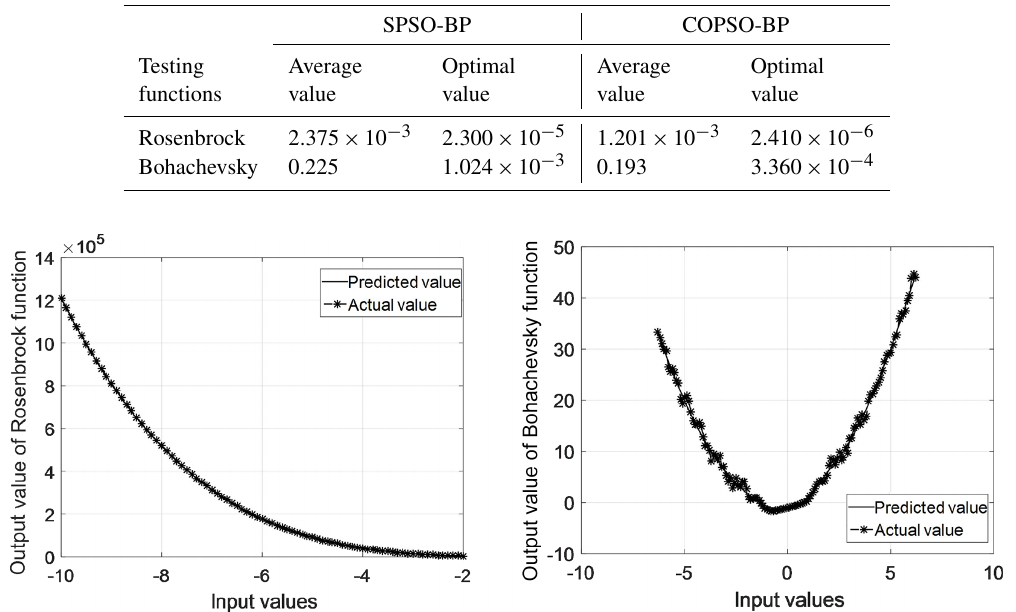
Table 1. Comparison of the SPSO-BP and COPSO-BP algorithms for testing functions.